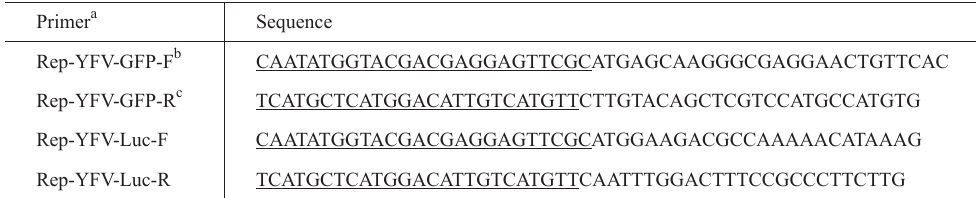
Primers used in the construction of subgenomic replicons